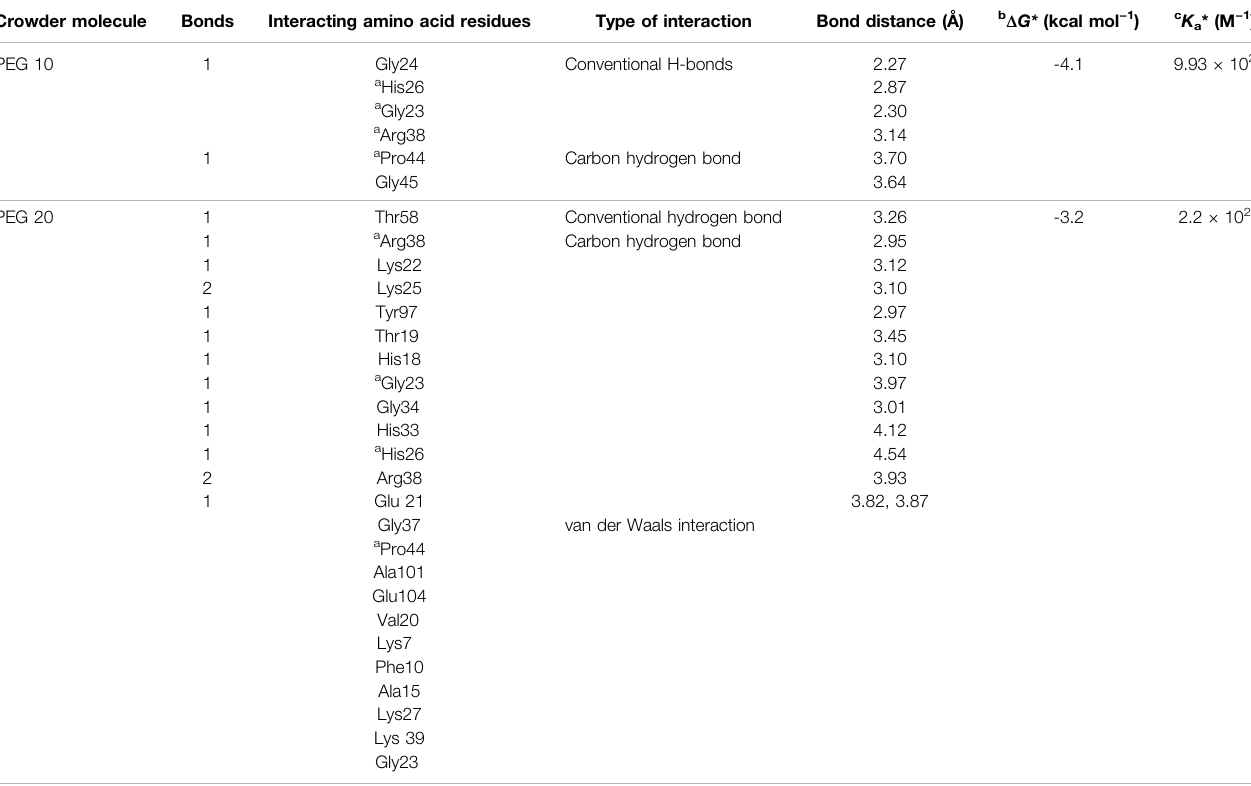
TABLE 4 | Binding parameters obtained and various types of interactions observed in between crowders (PEG 10 and PEG 20) and cyt c by molecular docking. Crowder